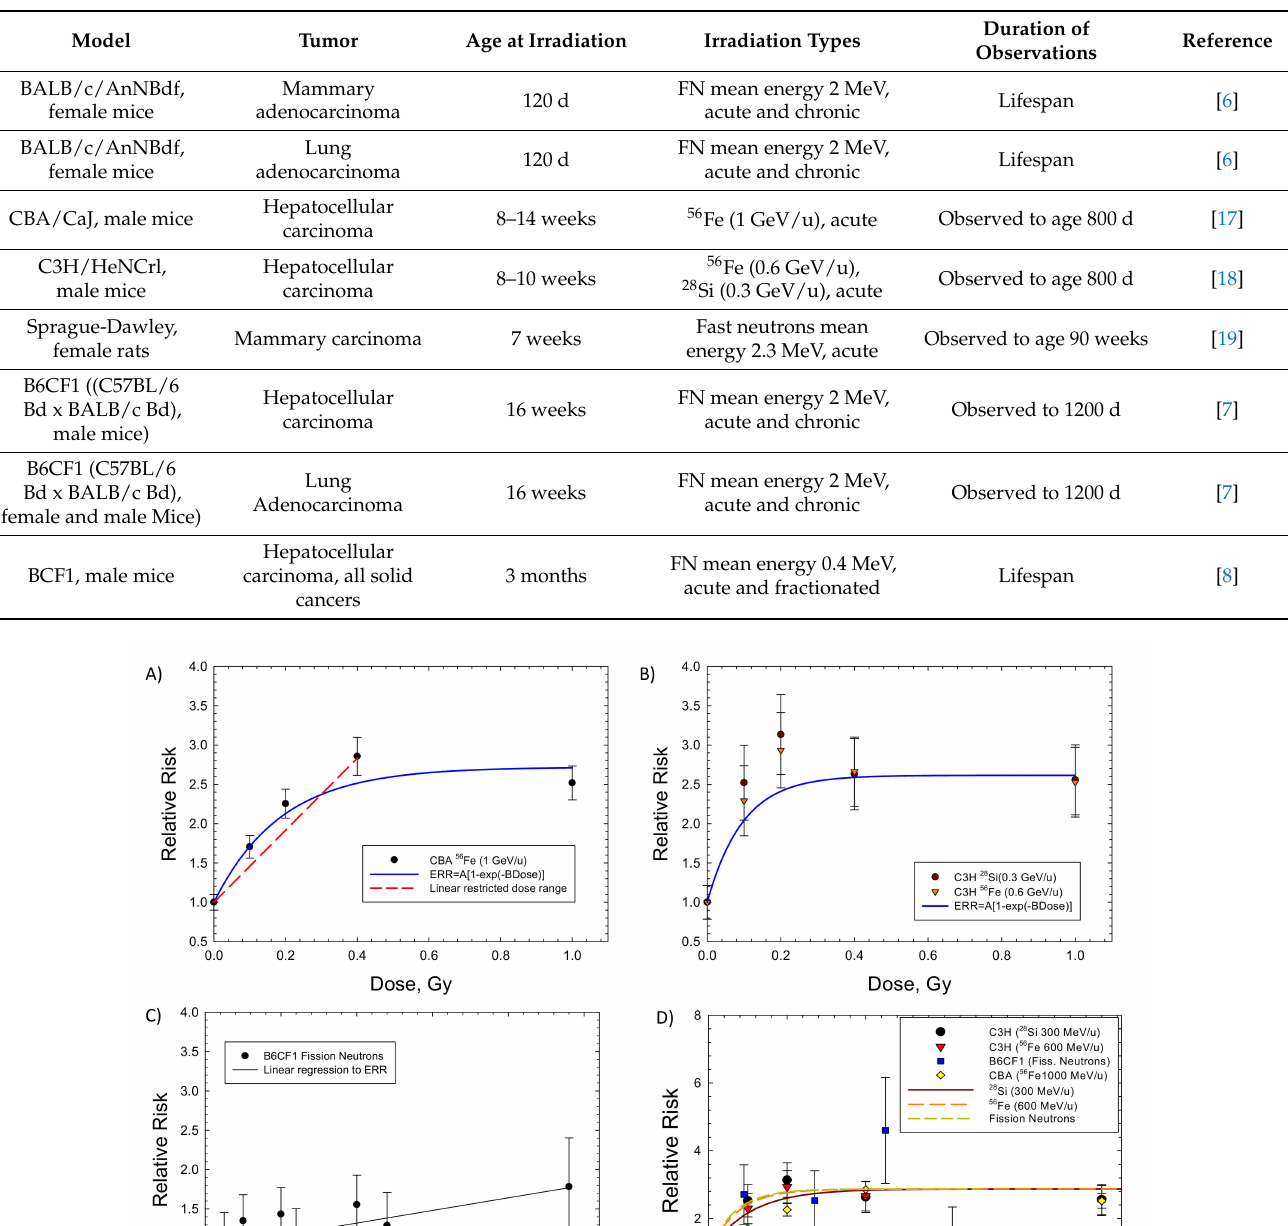
Table 2. Sources of tumor data in mice and rats exposed to fission neutrons (FN) or heavy ions. Data are chosen as representative of major cancer types in humans where more than one animal strain was reported at doses of high-LET radiation below 0.5 Gy, and with observation periods for tumor appearance representative of the animal lifespan. Doses used in the various studies are shown in the Figures of the present report.